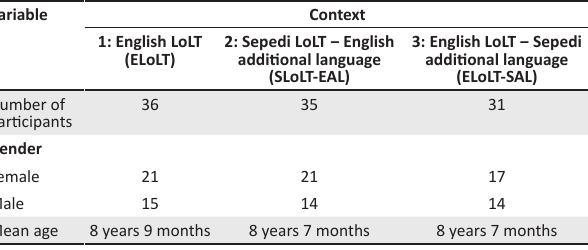
TABLE 1: Description of